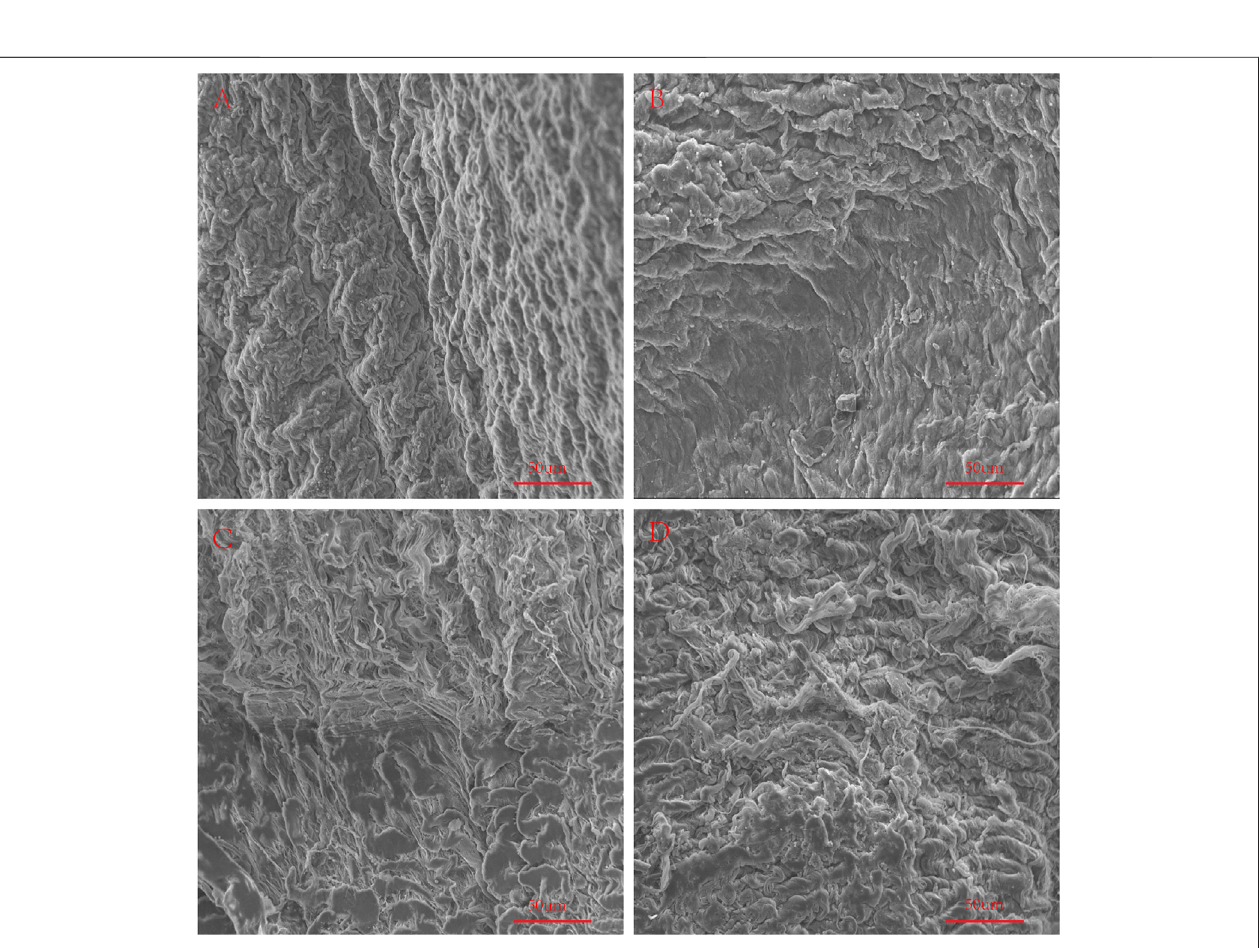
FIGURE 11| Use SEM toobservethe surface structure of Fold samples. (A) , Fold-yak pericardium; (B) , Fold-Australian bovine pericardium; (C) , Fold-local bovine pericardium; (D) , Fold-porcine pericardium. scale bars are 50 um.